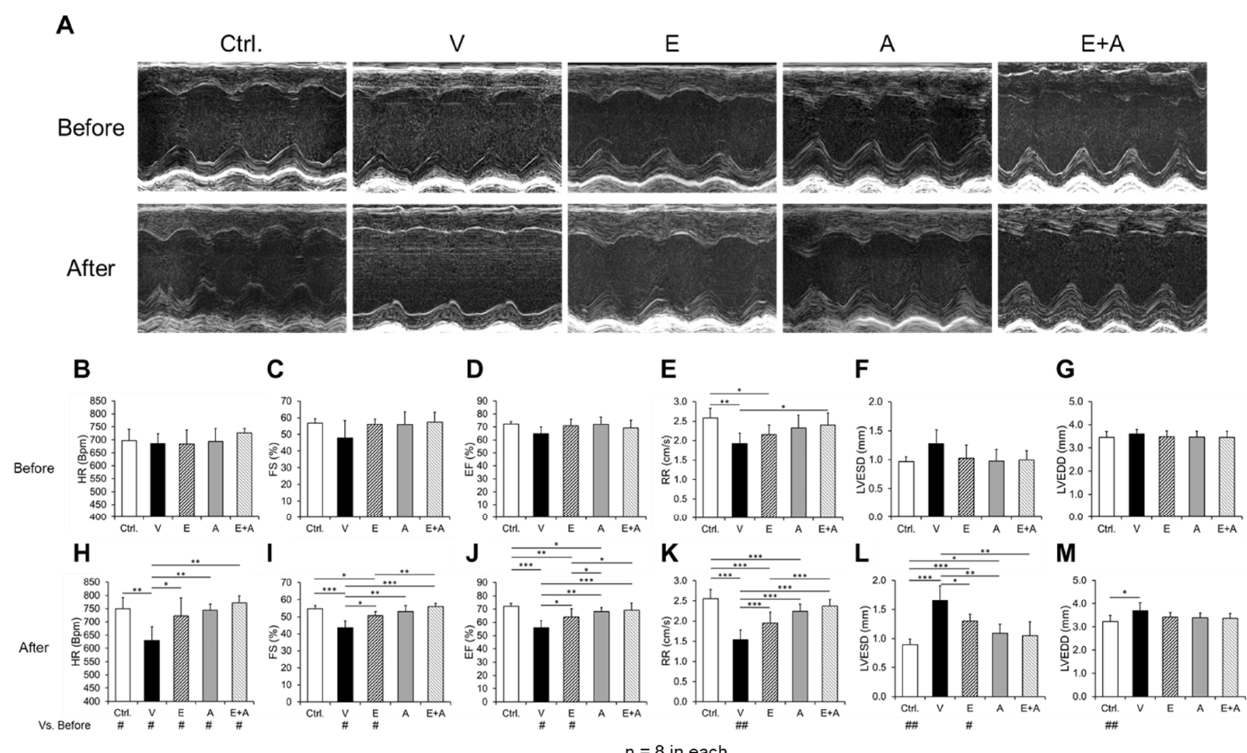
Figure 2. Changes in cardiac functional indices in diabetic ALDH2*2 mutant mice exhibiting HFpEF with vehicle, EMP, Alda-1 and EMP + Alda-1 treatments. The representative ultrasound images of our experimental groups were shown ( A ). Cardiac functional parameters measured before exercise stress: heart rate (HR) ( B ), % fractional shortening (FS) ( C ), % ejection fraction (EF) ( D ), relaxation rate (RR) data ( E ), left ventricular end-systolic diameter (LVESD) ( F ) and left ventricular end-diastolic diameter (LVEDD) ( G ) were shown from non-diabetic control ALDH2*2 mutant mice (Ctrl.), vehicle-treated ALDH2*2 mutant diabetic mice (V), EMP-treated ALDH2*2 mutant diabetic mice (E), Alda-1 treated ALDH2*2 mutant diabetic mice (A) and EMP and Alda-1 combinedly treated ALDH2*2 mutant diabetic mice (E + A). The cardiac functional parameters changes after exercise stress were shown as below: HR ( H ), % FS ( I ), % EF ( J ), and RR ( K ), LVESD ( L ) and LVEDD ( M ). Data are presented as mean ± standard error of the mean (SEM). n = 8 per group. * p < 0.05, ** p < 0.01 and *** p < 0.001 refer to the difference between individual groups as shown in before and after exercise stress. # p < 0.05 and ## p < 0.01 vs. before exercise stress of that particular group.